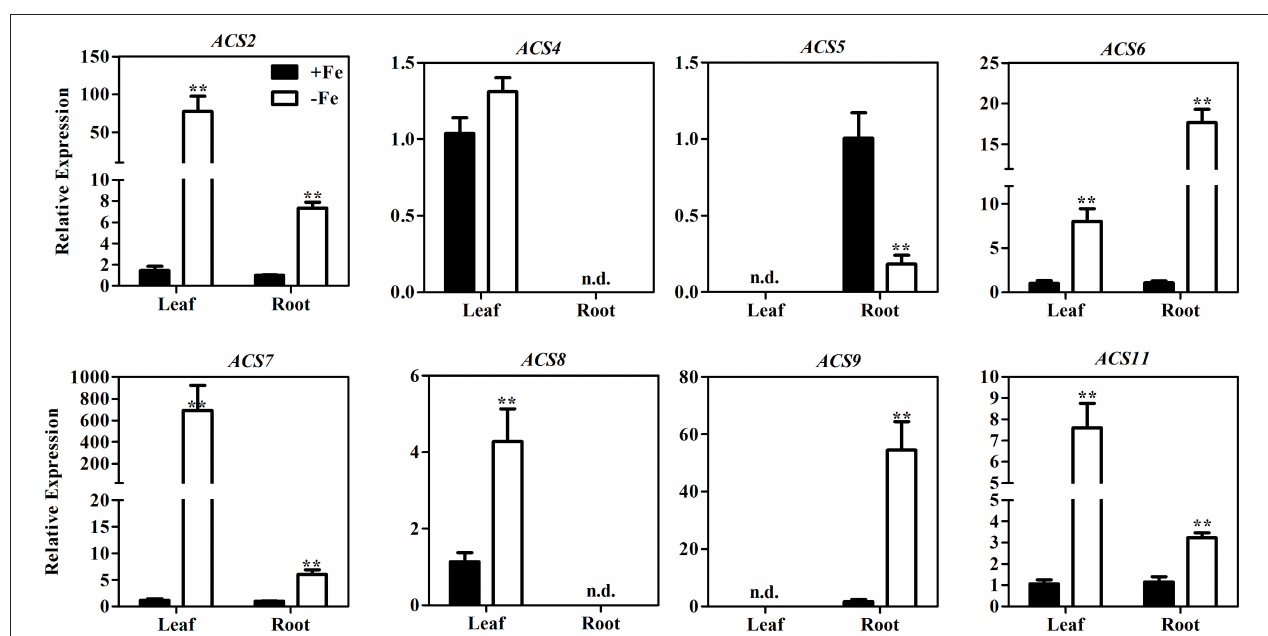
FIGURE 2 | Transcription levels of ACS genes in the leaves and roots of WT seedlings under Fe-sufficient ( + Fe) and -deficient ( − Fe) conditions. One-month-old seedlings were transferred to + Fe (50 µ M EDTA-Fe) or − Fe (0 µ M EDTA-Fe) nutrient solutions for 7 days. Leaves and roots were collected for RNA extraction. All values are expressed relative to the expression level under Fe-sufficient conditions (control—set to 1.0) as appropriate. Data are shown as the mean ± SEM ( n = 3 ). Column marked with “ ** ” indicate a highly significantly difference ( P < 0.01 ). n.d. indicates “not detectable.”